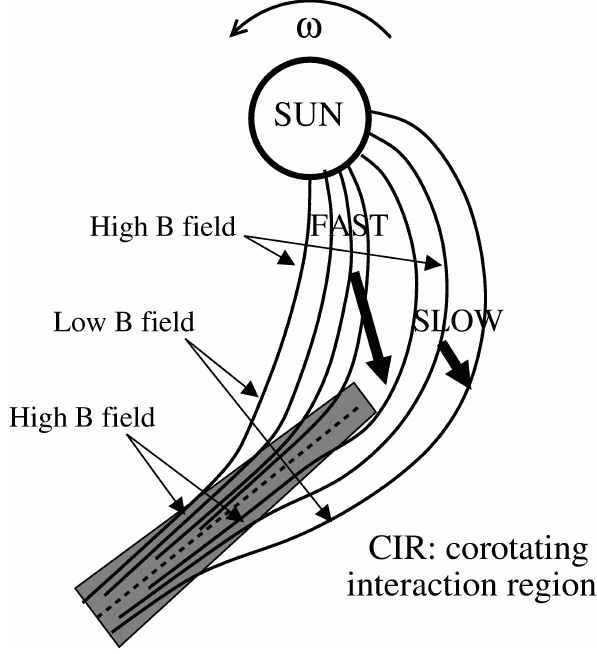
Fig. 2. Schematic of the structure of a corotating interaction re- gion (CIR) in the solar wind which may lead to (1) magnetic field strength profiles, along a given field line, like that depicted in Fig. 1 in both the high-speed and low-speed solar wind each side of the compression region, as well as (2) the formation of forward and re- verse shocks bounding the compression region (long edges of the grey area). The stream interface (SI) is identified here as the dashed line inside the